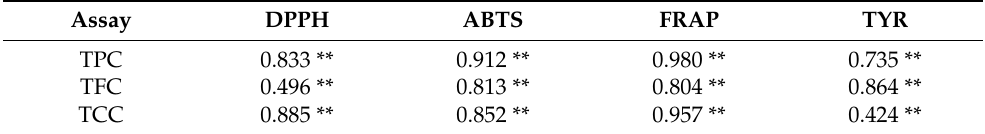
Table 5. Pearson’s correlation coefficients among total phenolic content (TPC), total flavonoid content (TFC), total carbohydrate content (TCC), antioxidant activities, and tyrosinase-inhibitory activity. Assay DPPH ABTS FRAP TYR TPC 0.833 ** 0.912 ** 0.980 ** 0.735 ** TFC 0.496 ** 0.813 ** 0.804 ** 0.864 ** TCC 0.885 ** 0.852 ** 0.957 ** 0.424